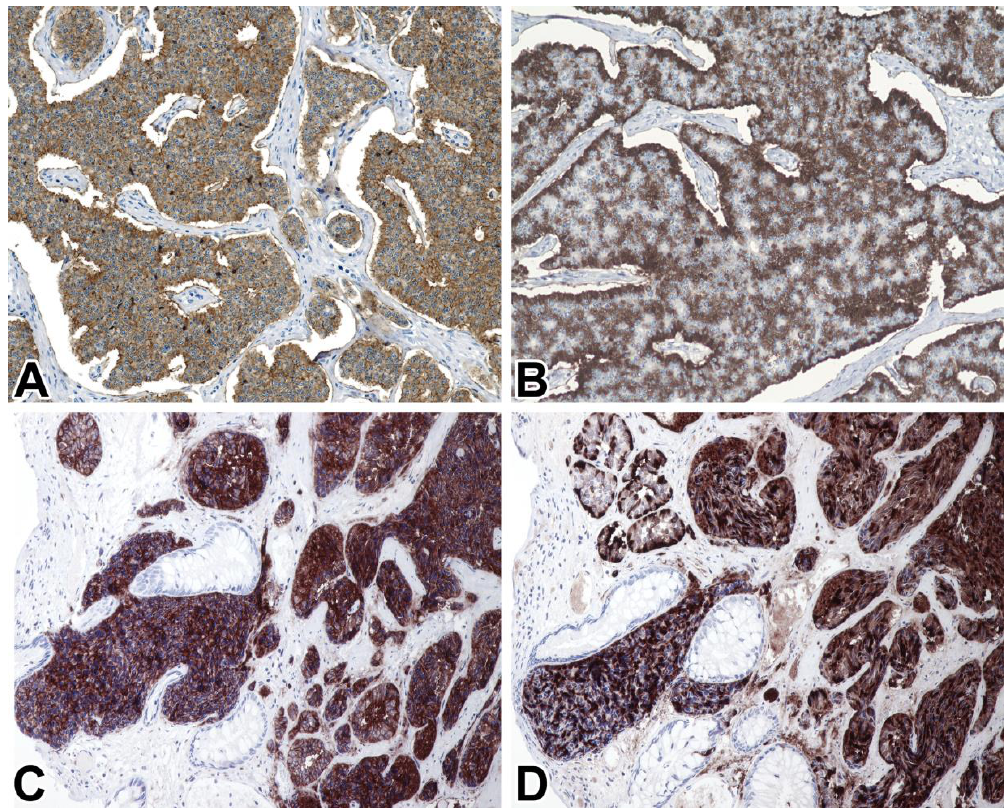
Figure 3. STX1 (A, C) vesicular monoamine transporter 1 (VMAT1), (B) and glucagon-like peptide 1 (GLP1) (D) immunoreactivity in a small intestinal enterochromaffin ( EC) cell NET grade 2 (A, B) and a rectal L cell NET grade 1 (C, D) . 20x.